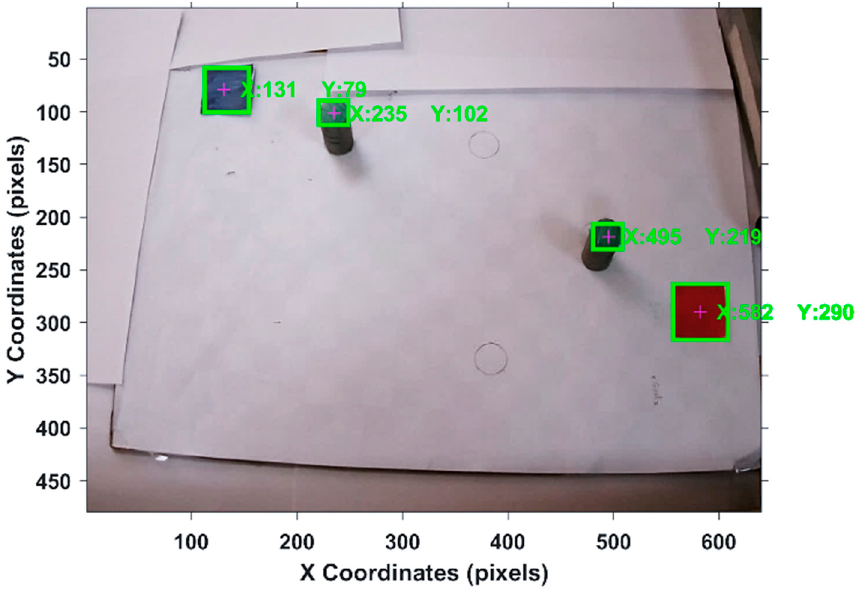
Figure 9. Live Camera Feed With Start, Goal, and Obstacle Positions for Online Vision-Based Path Planning. Table 1. Transformed Coordinates of Colored Objects Placed in Robot Workspace.